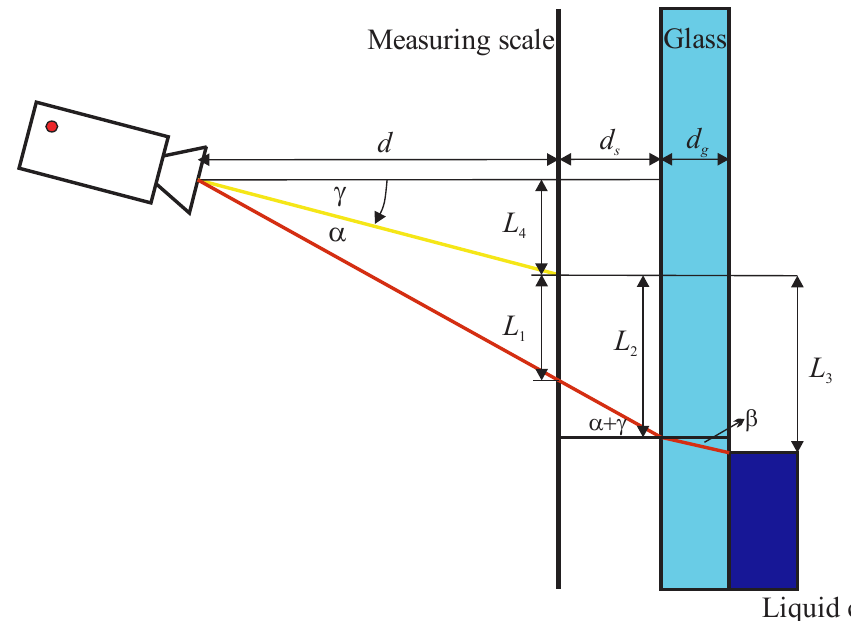
Figure 4. Scheme of the parallax effect for the tilted camera.